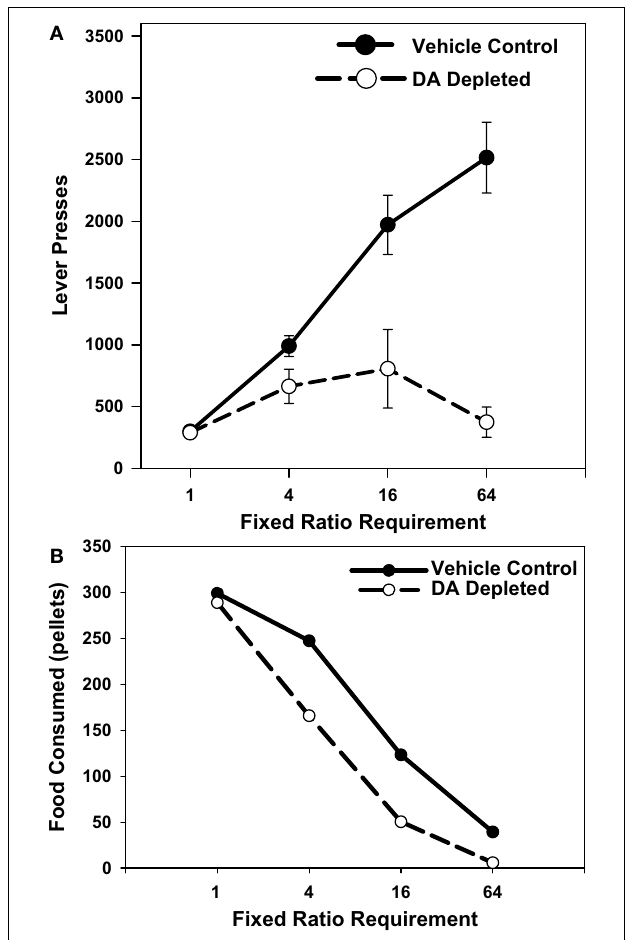
FIGURE 1 | This fi gure shows the effect of ratio requirement on the number of lever presses emitted and operant pellets consumed in rats with accumbens DA depletions compared to rats in the vehicle control group. Figure (A) is re-drawn based upon Aberman and Salamone (1999); these data are depicted in terms of number of responses, as in the original article. For (B) , the data are represented as number of operant pellets consumed. Each data point shown is the mean value from each group at each ratio level. Although comparable levels of consumption in DA depleted and control groups were seen with the FR1 schedule, DA-depleted rats showed markedly reduced consumption relative to the control group at higher ratio